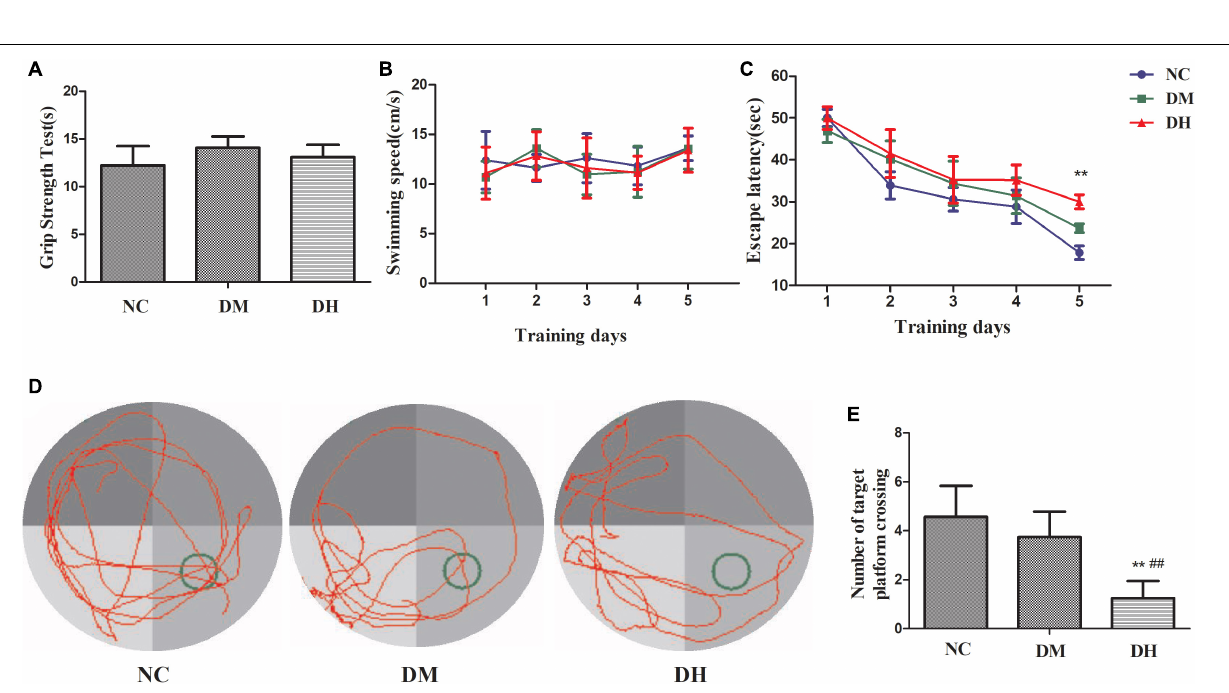
Frontiers in Aging Neuroscience |